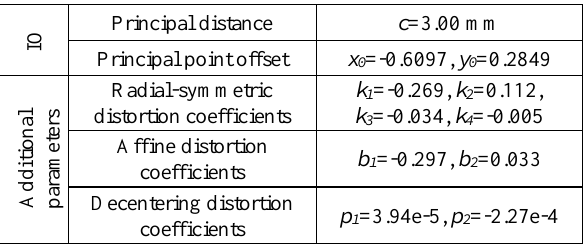
Table 2. Example of camera calibration parameters estimated for one of GoPro 4 Black ®